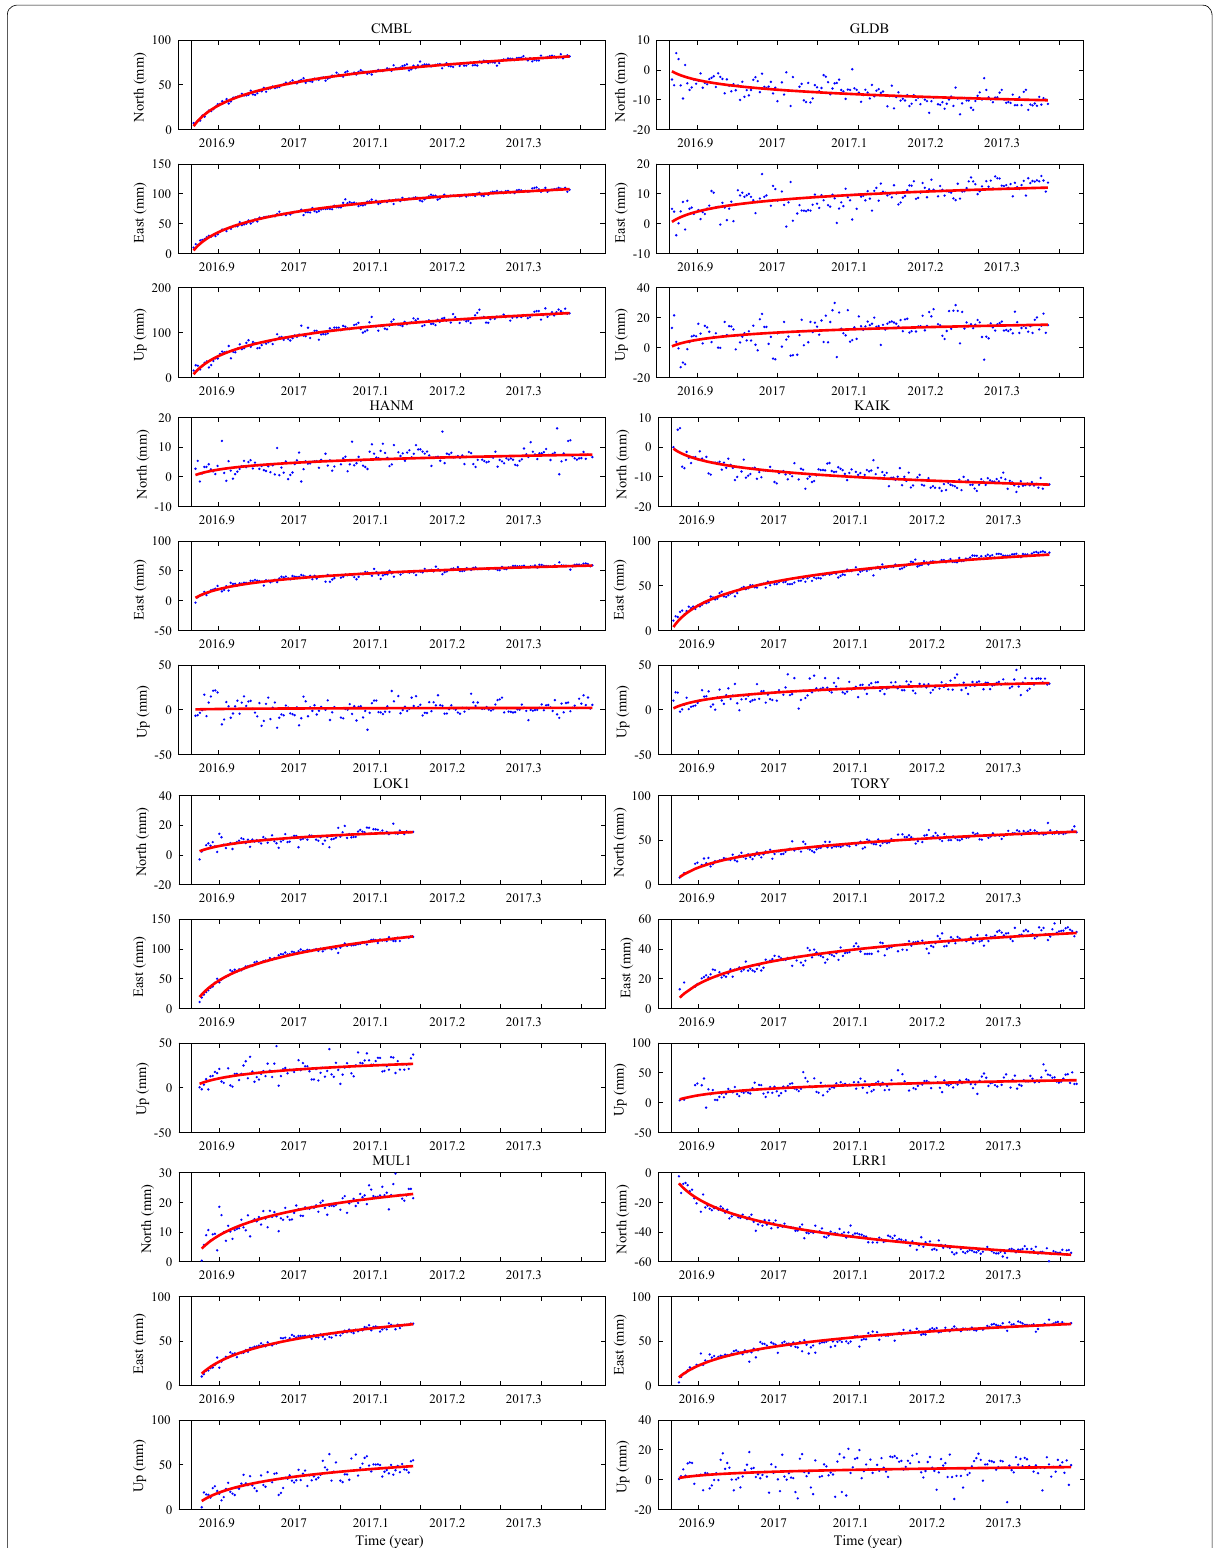
Fig. 3 Raw (blue dots) and fitted (red line) position time series (long-term rates and seasonal signals were removed) at several representative sta- tions in the postseismic